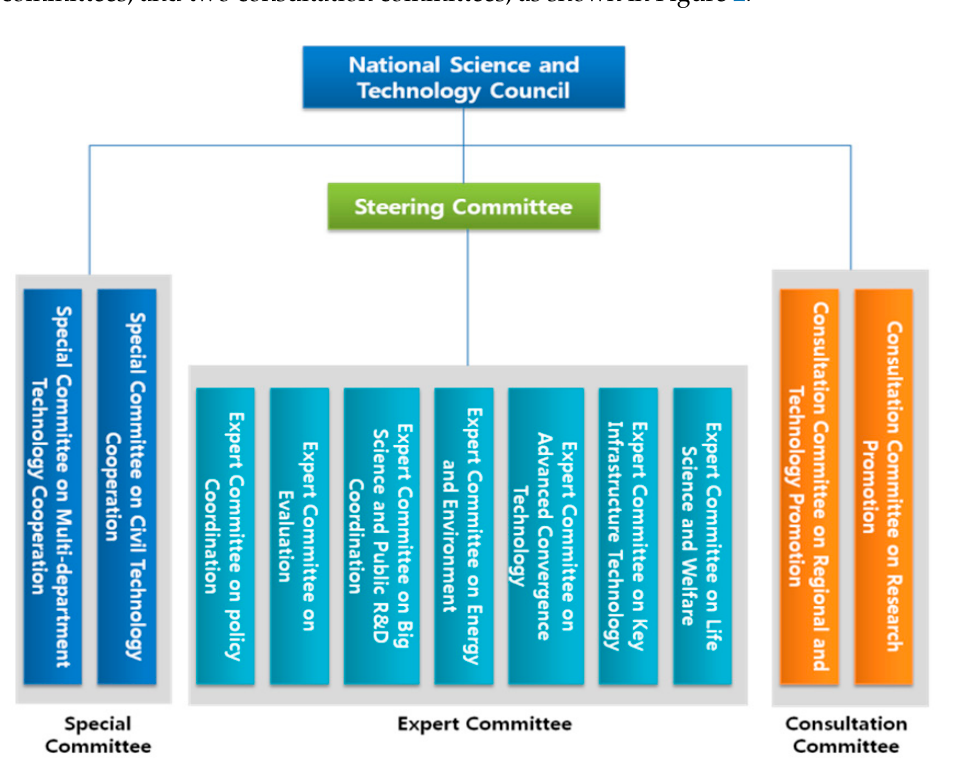
Figure 2. Organizational Structure of the NSTC.